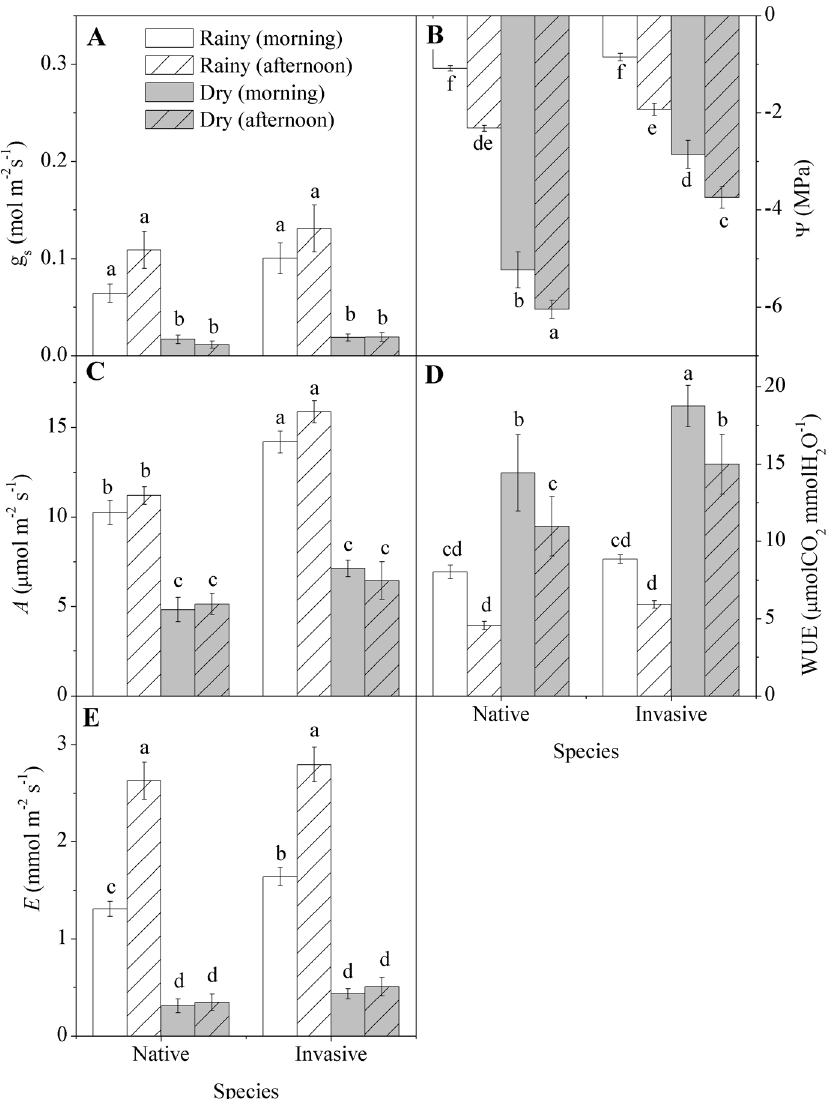
Figure 2. Changes in gas exchange in native ( Anadenantheracolubrina) and invasive ( Prosopisjuliflora ) species in a tropical dry forest in Brazil across seasons: (A) stomatal conductance (g s ), (B) water potential ( Y l ), (C) CO 2 assimilation ( A ), (D) water use efficiency (WUE= A / E ), (E) transpiration ( E ). Values represent the average of replicates (n=20 6 SE; invasive dry season n=25 6 SE). Different letters denote statistical differences by Newman-Keul test with significance level of 5 percent between